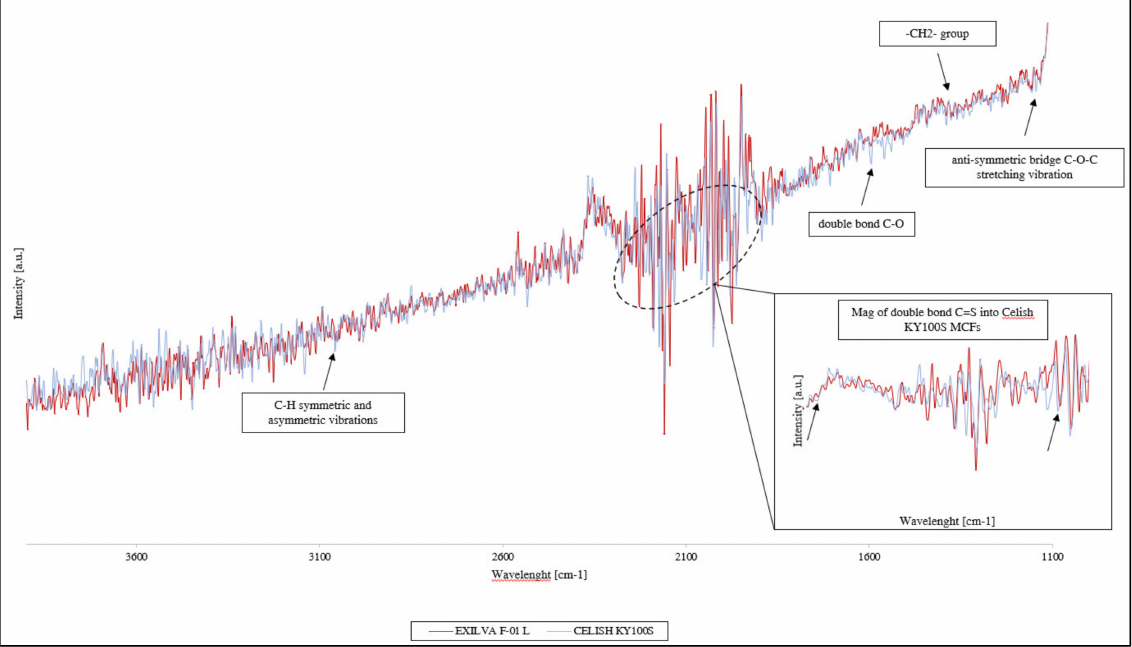
Figure 3. ATR-FTIR spectra of Exilva F 01-L, Borregaard, and Celish